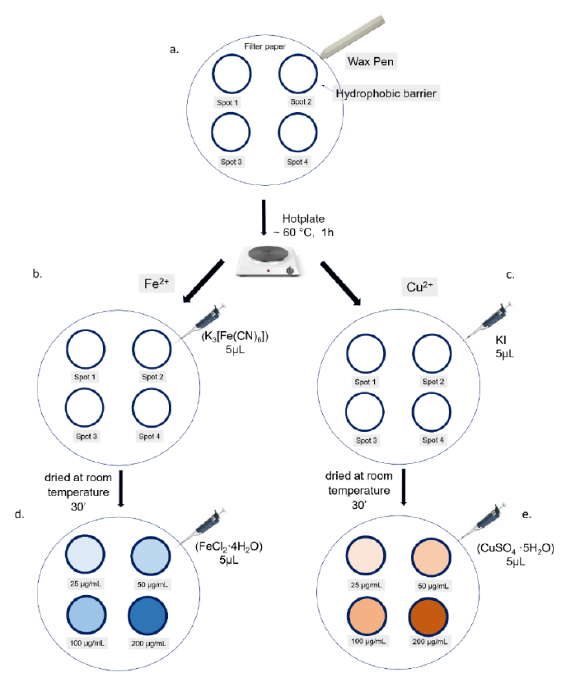
Figure 2. Schematic Fe 2 + and Cu 2 + colorimetric assay procedure : ( a ) The four spots were achieved by wax pen in order to create hydrophobic barriers after heating using a hot plate. ( b , c ) Five microliters of each standard solution were added by drop-casting to the corresponding labeled spot. ( d ) On the Fe(II) paper-based analytical device (PAD), a blue complex was formed after the reaction between the Fe 2 + and ((K 3 [Fe(CN) 6 ]); the blue color intensity directly correlated with the Fe 2 + concentration ( e ) On the Cu(II) PAD a red-brown compound was developed, generating by Cu 2 + and KI reaction, whose color intensity was dependent on Cu 2 + concentration.